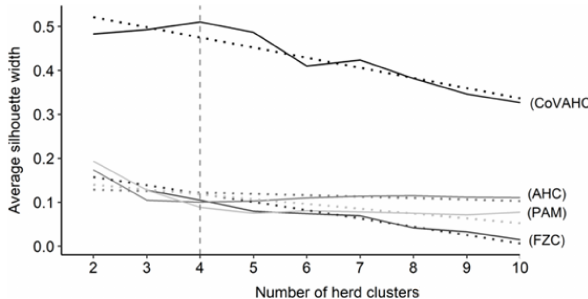
Figure 1. Average silhouette width for the different numbers of herd clusters considering the following clustering approaches: agglomerative hierarchical clustering (AHC), partition around medoids (PAM), fuzzy clustering (FZC), clustering of variables combined with agglomerative hierarchical clustering (CoVAHC); dotted lines are smoothed conditional means; the vertical dotted line indicates the chosen number of herd clusters for ongoing